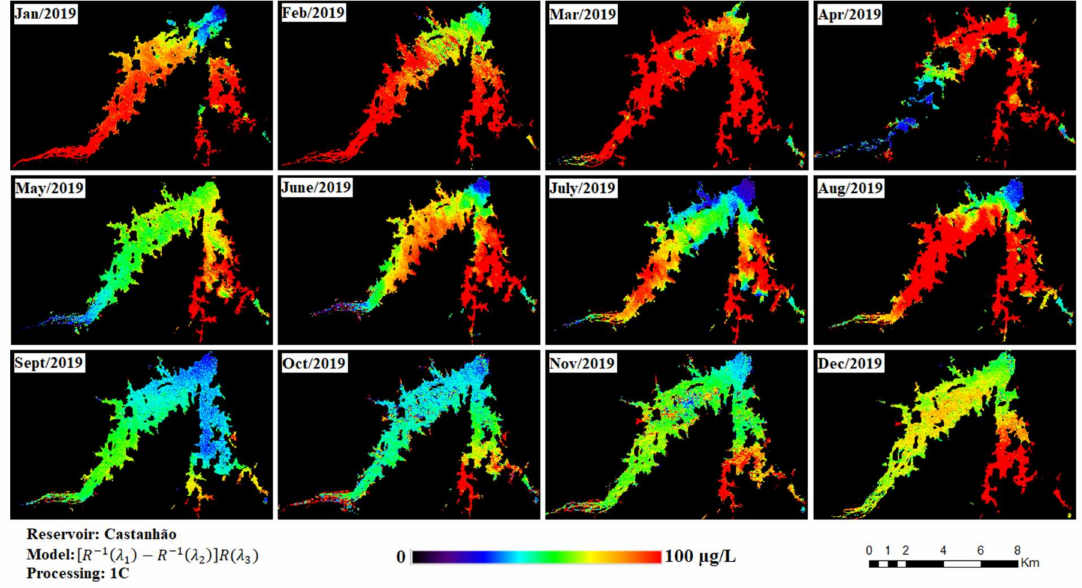
Figure 7. Monthly map of the concentration of chl-a in the Castanh ã o reservoir, during 2019, produced from the 1C level TOA products and the three-band model (Equation